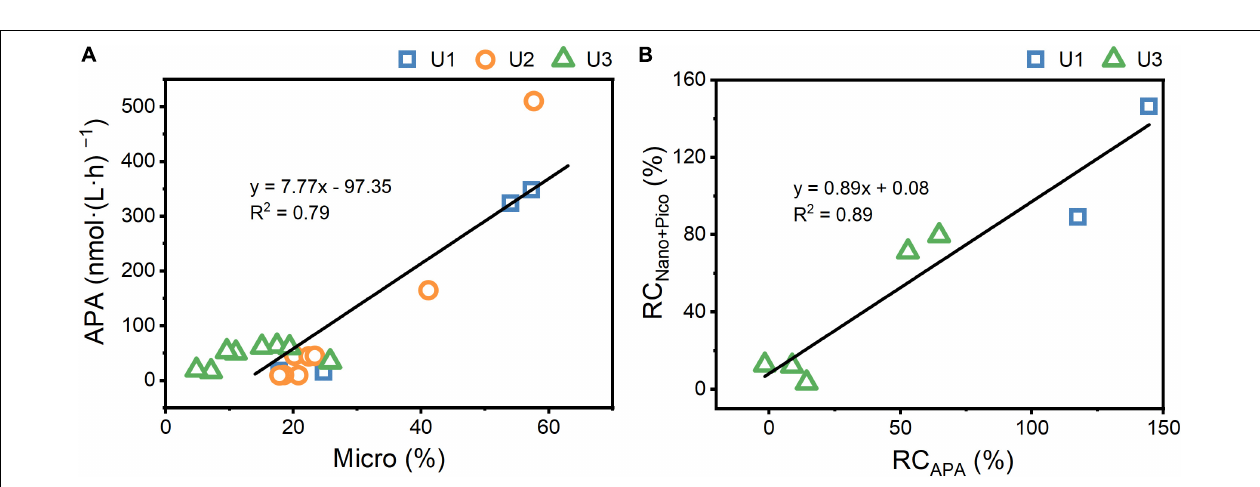
FIGURE 7 | Correlations between species (level 3) and environmental factors based on redundancy analysis (RDA).